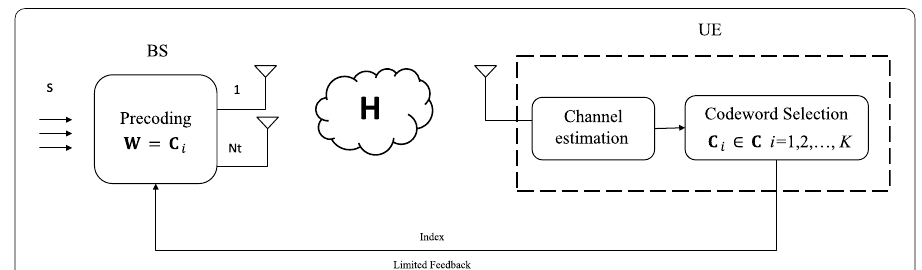
Fig. 1 Overview of the proposed limited feedback massive MIMO